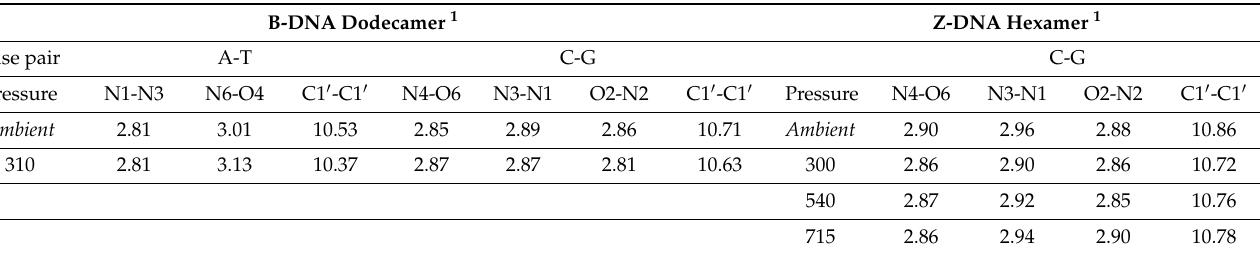
Table 5. The average values of the Watson–Crick base pair distances in Å versus the applied pressure measured in the refined structures. To avoid bias resulting from refinement steps, the distances within the base pairs were not restrained. Pressures are in MPa. (Ambient structures are 1bna and 2elv for B- and